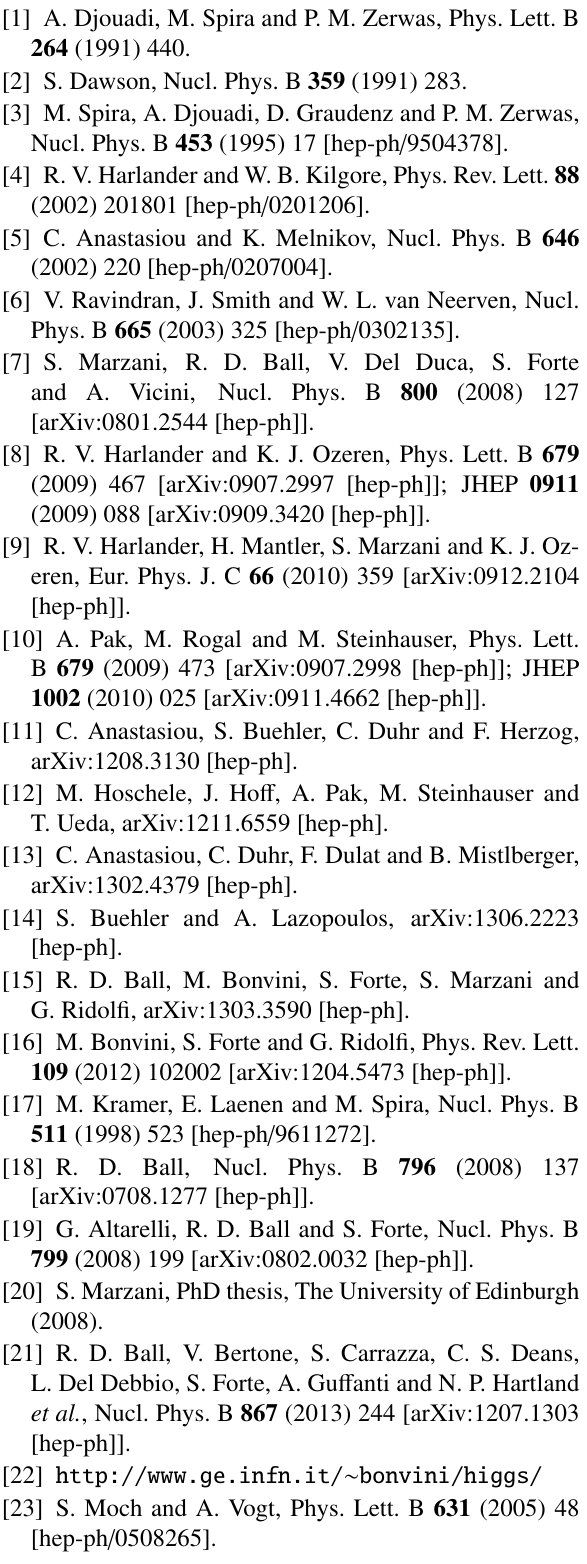
Figure 3. Same as Fig. 2 for for the unknown δ (1 − z ) term at order α 3